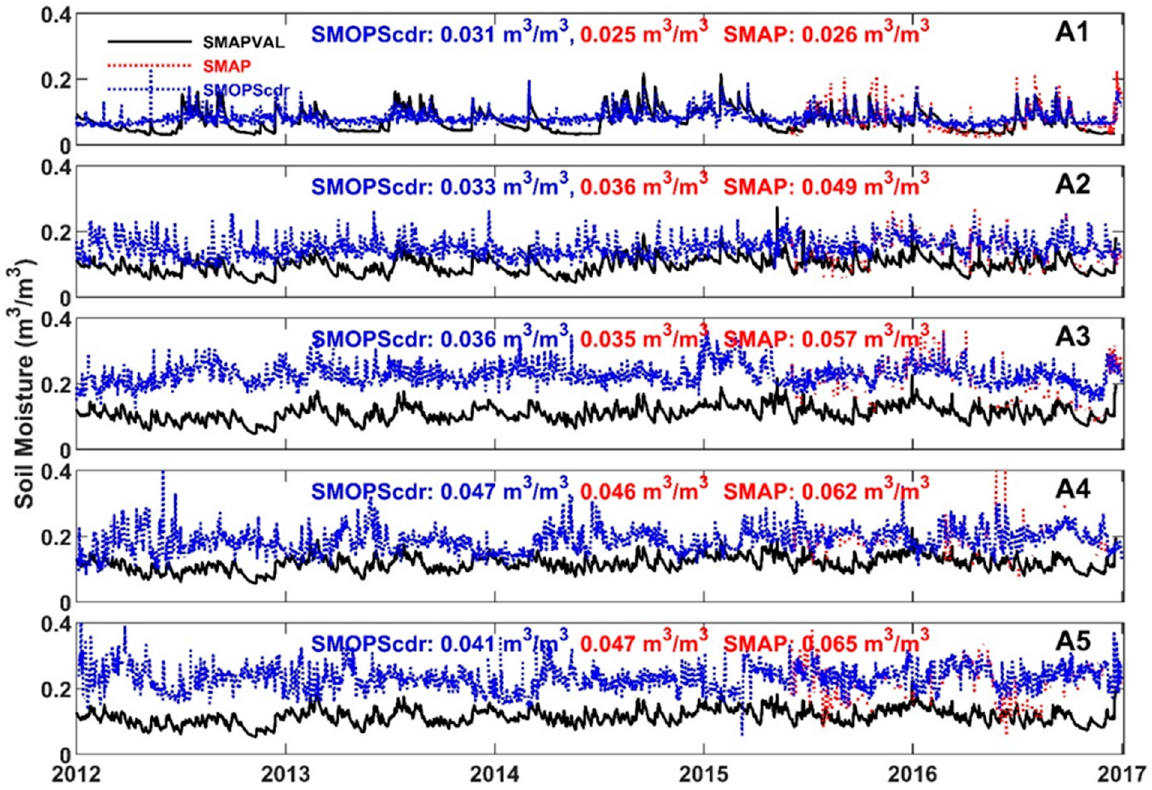
Figure 4. The watershed-averaged daily SMOPScdr and SMAP data versus daily SMAPVAL soil moisture measurements: A1—Walnut Gulch watershed, A2—Little Washita and Fort Cobb water- shed, A3—Little River watershed, A4—St. Joseph’s experimental watershed and A5—South Fork experimental watershed. The SMAP is from 1 April 2015 to 31 December 2016, while SMOPScdr starts from 1 January 2012. The ubRMSEs in blue and red colors for SMOPScdr indicate the time period before and after 1 April 2015 when SMAP becomes available. The ubRMSEs in red color for SMAP indicate the assessment over 1 April 2015 to 31 December 2016 period.